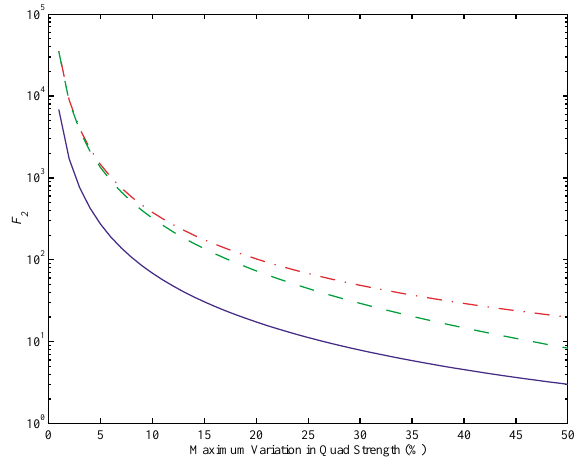
FIG. 7. (Color) F 2 as a function of D K . Symmetric scans (blue solid line), monotonic scans towards zero strength (green dashed line), and monotonic scans away from zero strength (red dot-dashed line) are shown.